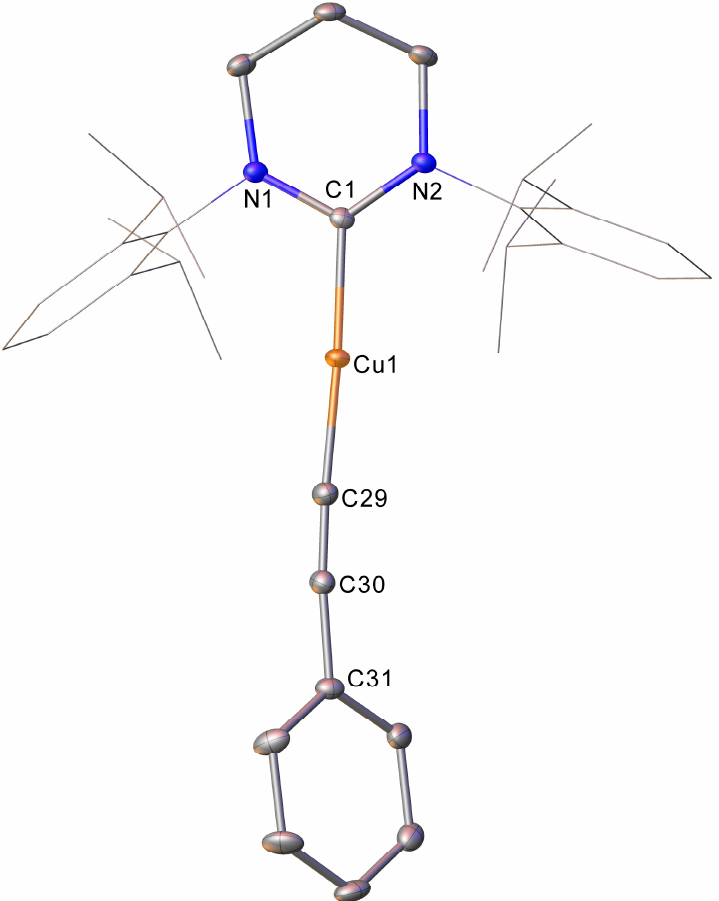
Figure 3. Molecular structure (30% probability ellipsoids) of 3 . Hydrogen atoms and the second disordered component have been omitted for visual clarity. Wireframe view has been employed for Dipp groups, also for visual simplicity. Selected bond lengths (Å), angles (°): N1-C1 1.339(3);